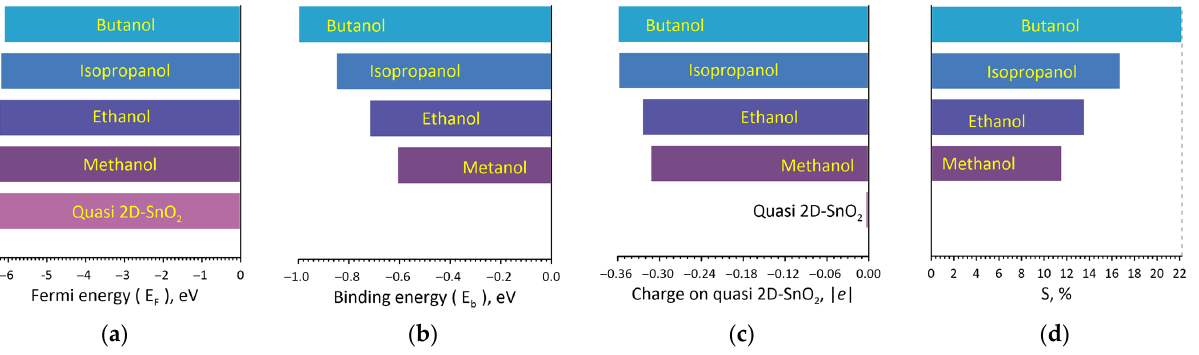
Figure 3. The diagrams of the Fermi energy ( a ), the alcohol–surface binding energy ( b ), the values of the charge transfer from the alcohol to the surface ( c ) and the magnitude of the chemoresistive response S of the quasi-2D SnO 2 thin films during adsorption of alcohols ( d